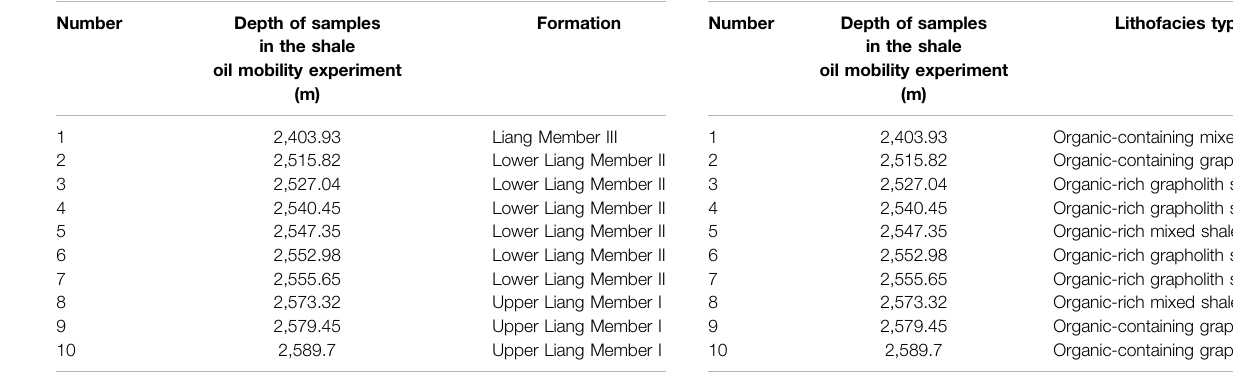
TABLE 4 | Lithofacies types of shale samples in the shale oil mobility